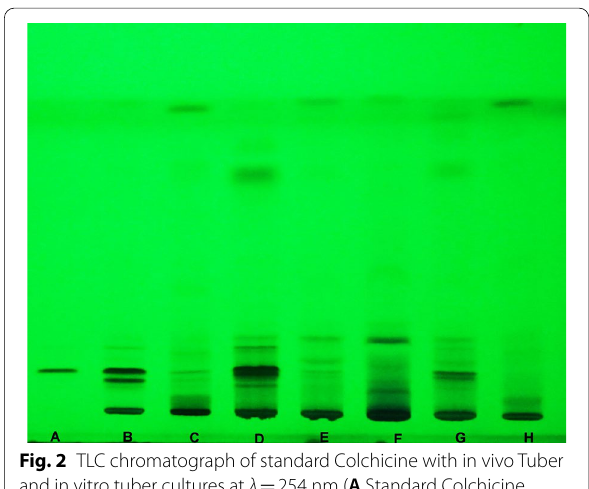
Fig. 2 TLC chromatograph of standard Colchicine with in vivo Tuber and in vitro tuber cultures at λ 254 nm ( A Standard Colchicine, = B in vivo tuber, C – H in vitro tubers with C 2 weeks, D 4 weeks, E